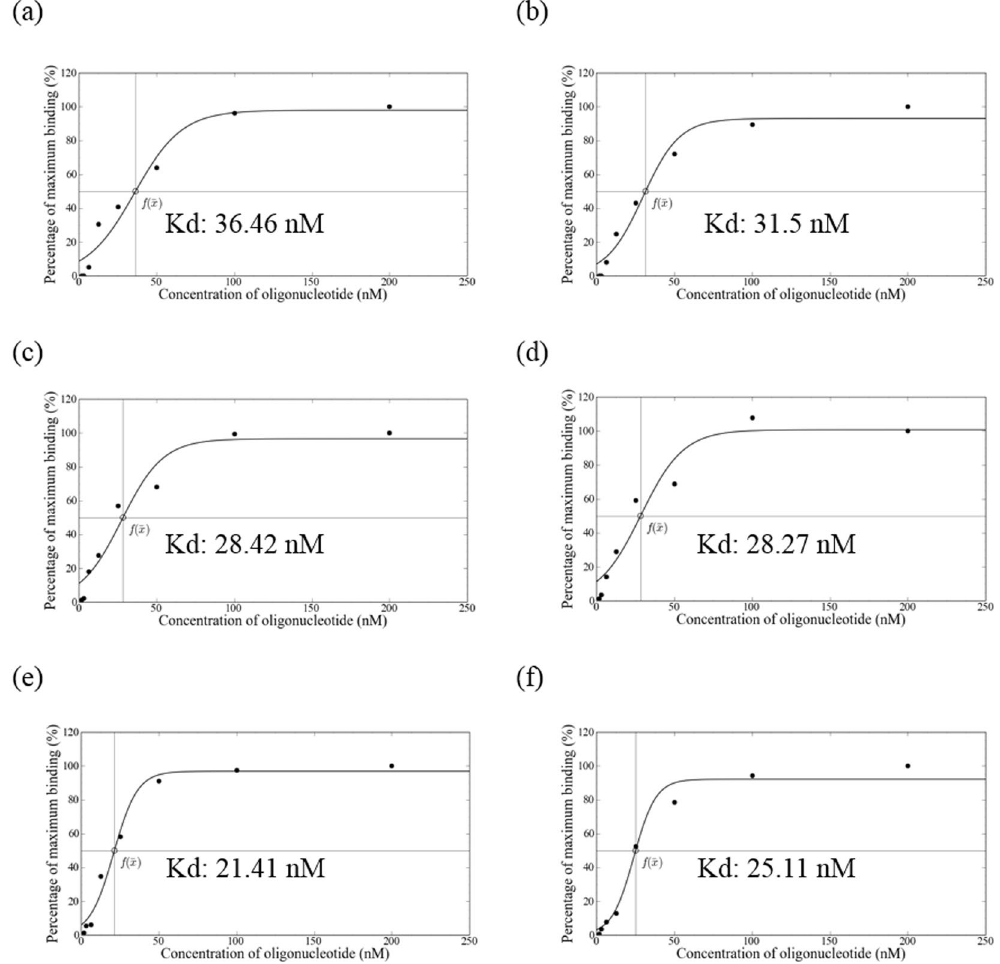
Figure 3. Equivalent dissociation constants of the specific aptamer (MP-1) toward multiple target analytes, ( a,b ) CRP, ( c,d ) HBs Ag, and ( e,f ) HCV NS3